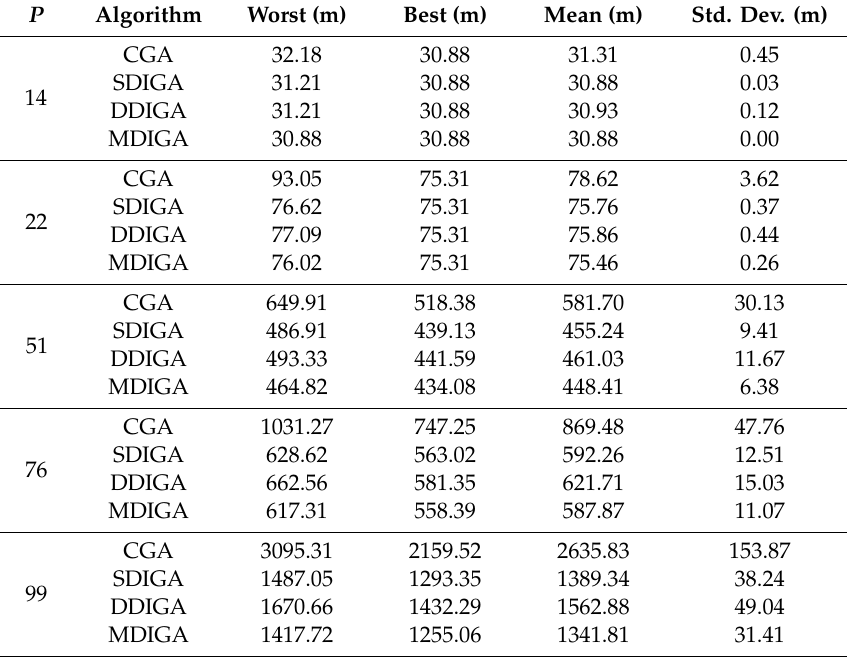
Table 4. Statistics results of optimal path distance in 100 runs with five numbers of planned